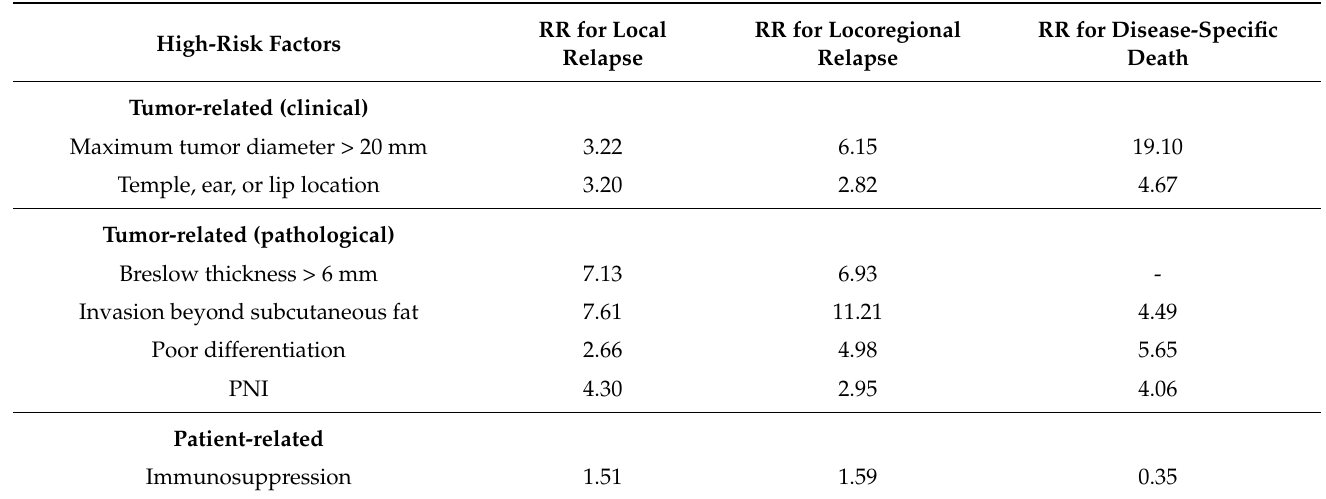
Table 4. Risk factors for cutaneous squamous cell carcinoma recurrence, metastasis, and disease- specific death.